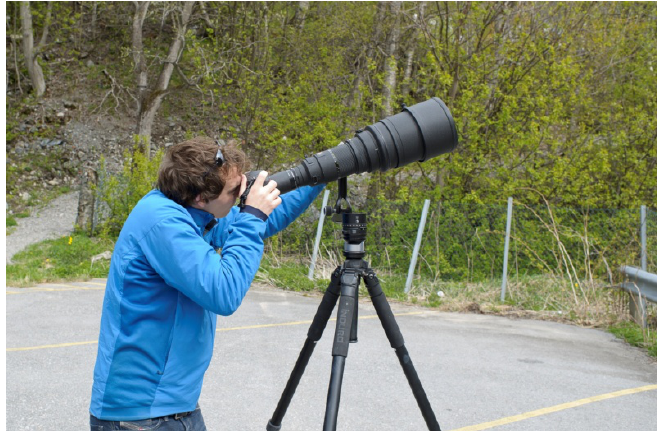
Figure 4. Manual Pano-Gimbal head with 400 mm and 2× teleconverter on D7000: effective focal length of 1,200